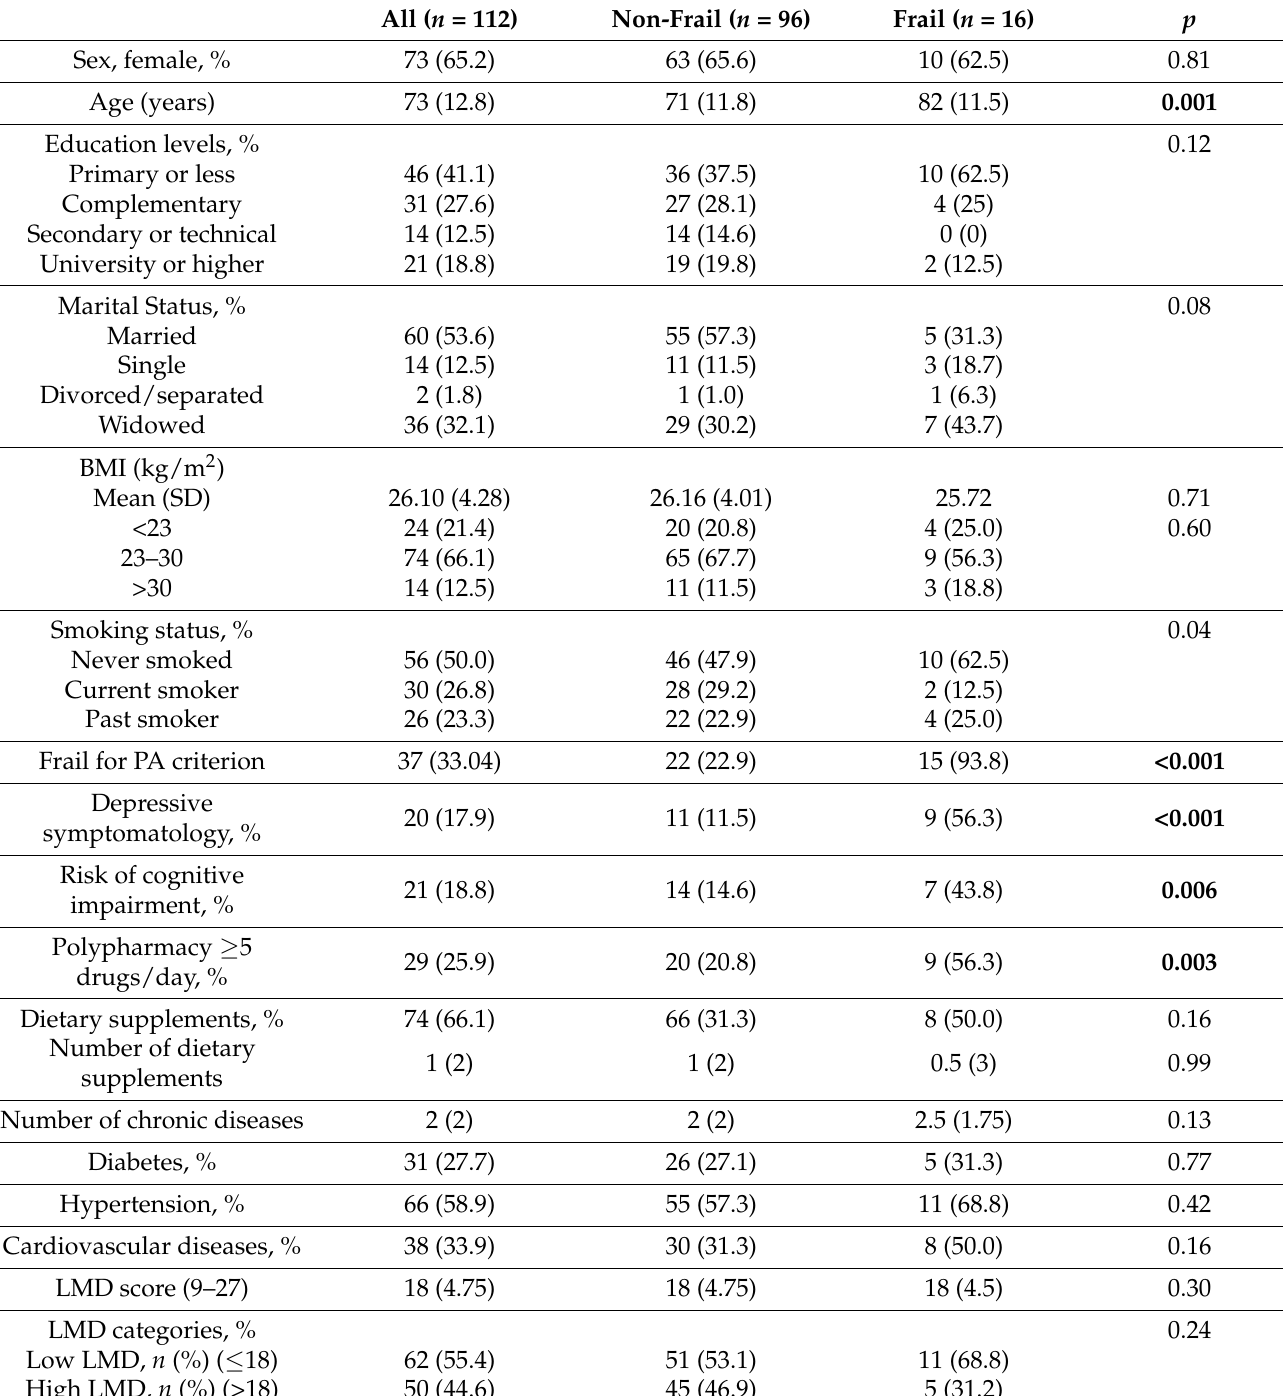
Table 1. Demographic and clinical Characteristics of study participants by frailty